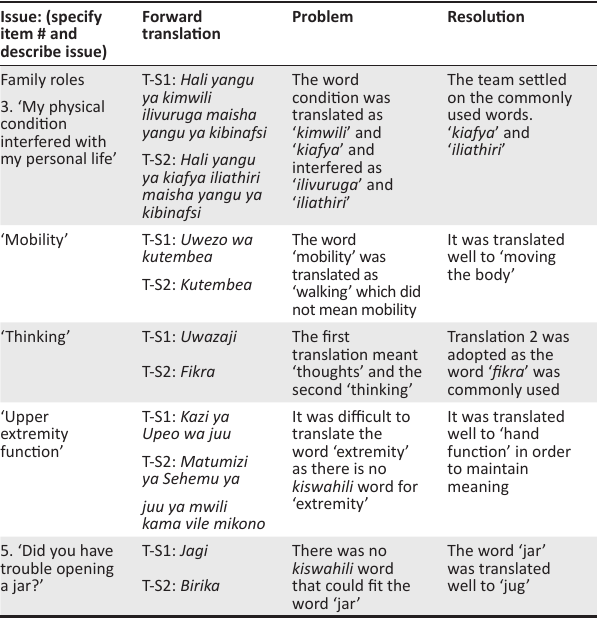
TABLE 1: Consensus Swahili